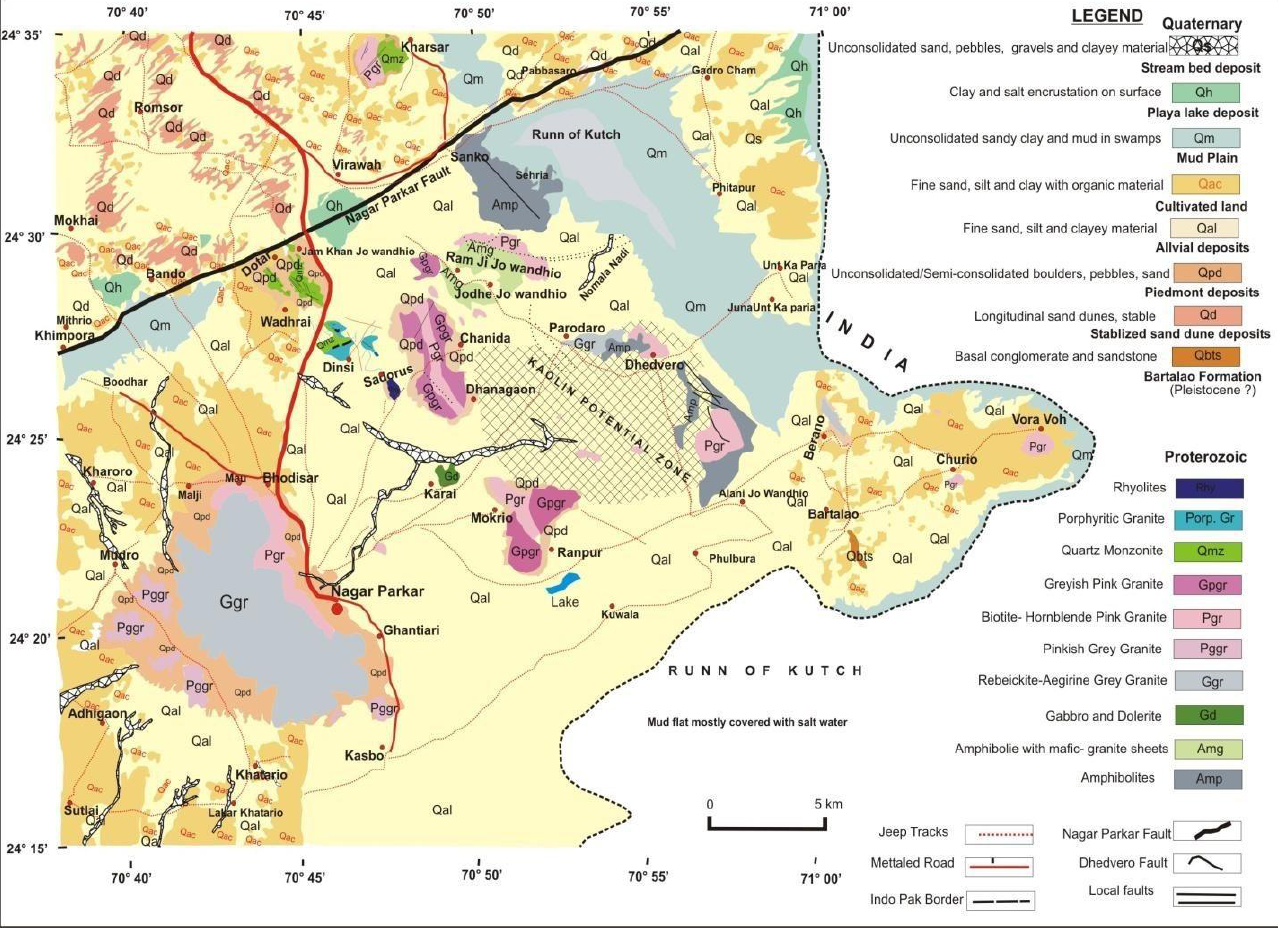
Figure 1. Simplified geological map of the Nagar Parkar igneous complex, SE Pakistan (modified after [16].